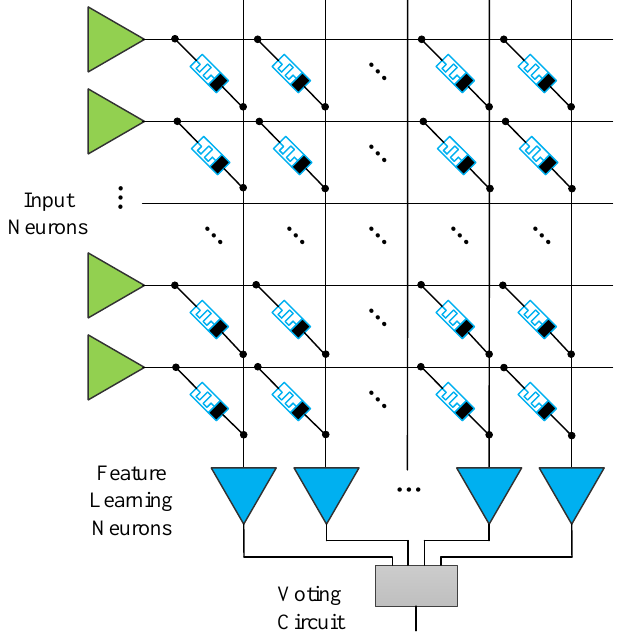
Figure 1. Schematic of the proposed